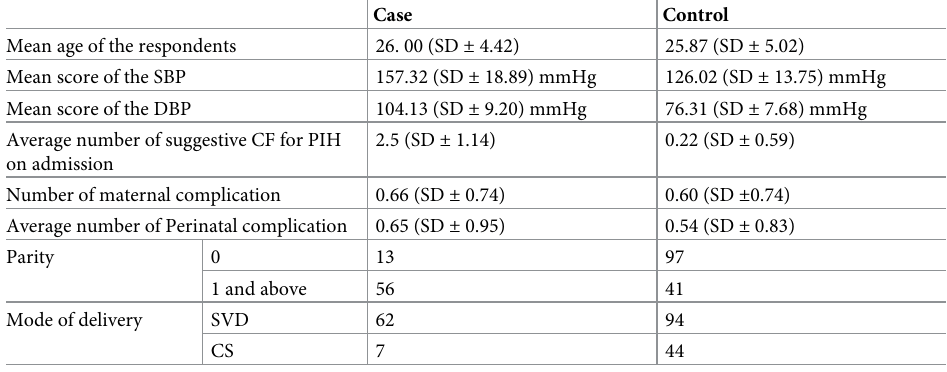
Table 3. Mean score and proportion of selected items among women gave birth in Hossana town administration, southern Ethiopia,